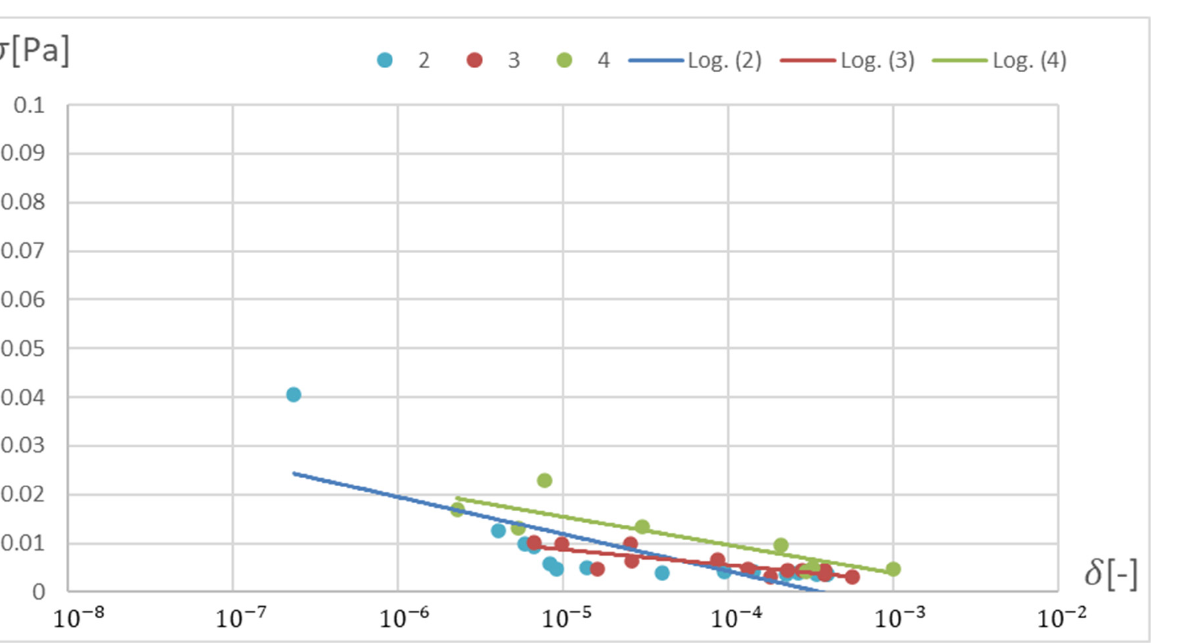
The RPROP algorithm for one hidden layer, excluding the network with two neurons, matches the training database worse than the SCG algorithm. The network trained with the SCG algorithm with two neurons in the hidden layer has the smallest relative error, and the network with two hidden neurons also trained with the SCG algorithm has the smallest standard deviation. Through the Pareto front, distinguished for a particular number of neurons in a layer by the combination of δ and σ , on the basis of the trend line, a qualitatively average ANN match to the selected database can be determined, as shown in Figures 20 and 21.